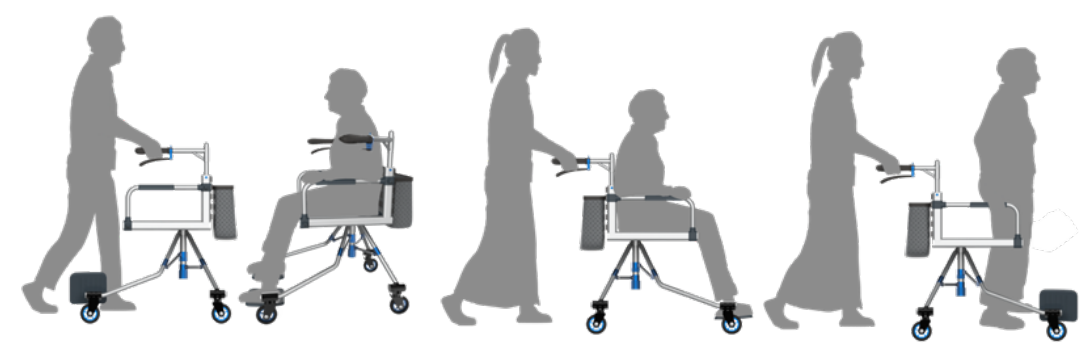
Figure 7. Specific application of the developed rollator.